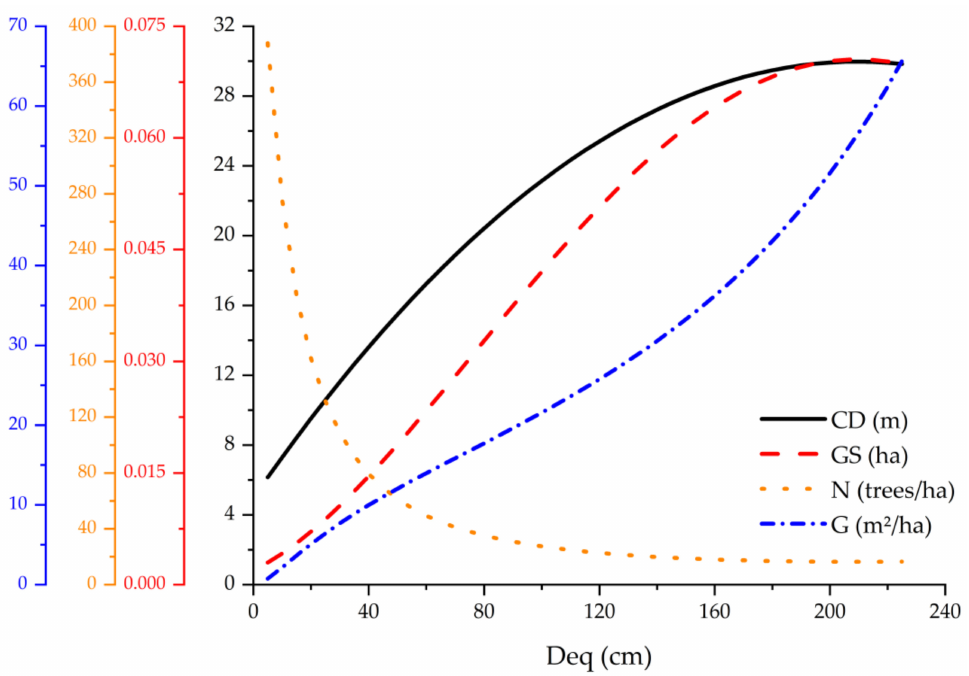
Figure 8. Evaluation of the necessary growth space, considering the size of the potential crown diameter in open-grown trees, in which CD (black line) refers to crown diameter; GS (red line), to grown space; N (yellow line), to the number of trees; and G (blue line), to their basal area.